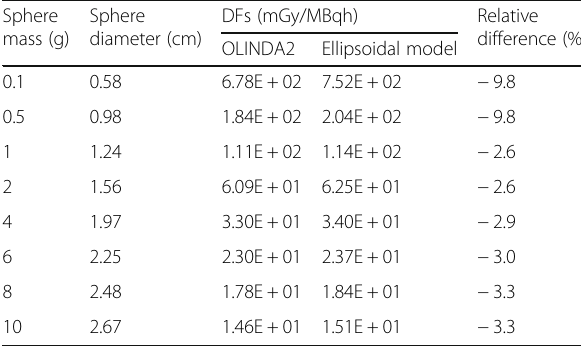
Table 3 Dose factors for 152 Tb uniformly distributed in spheres of unit-density tissue, according to OLINDA2 and to the ellipsoidal model described in [17 – 19]. Relative percent differences of OLINDA2 with respect to the ellipsoidal model are also